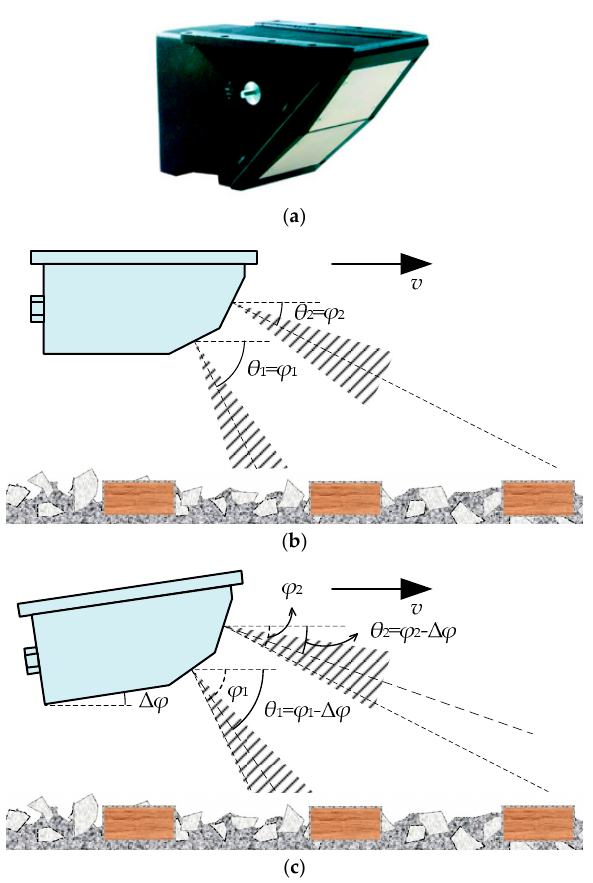
Figure 5. Train-borne dual-channel DRS: ( a ) Appearance view of DRS05; ( b ) Schematic diagram of working principle in the ideal situation without a deflection angle; ( c ) Schematic diagram of working principle in the actual situation with a deflection angle.